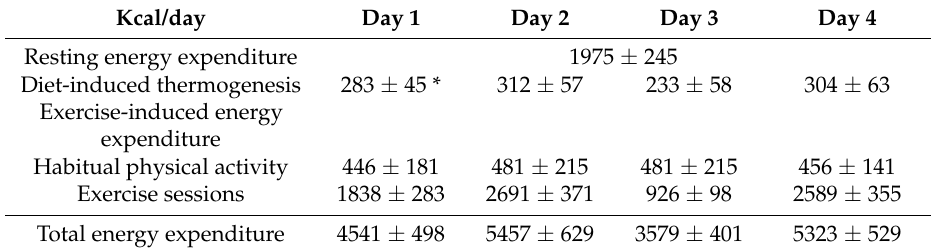
Table 5. Energy expenditure during the five-day experimental period.